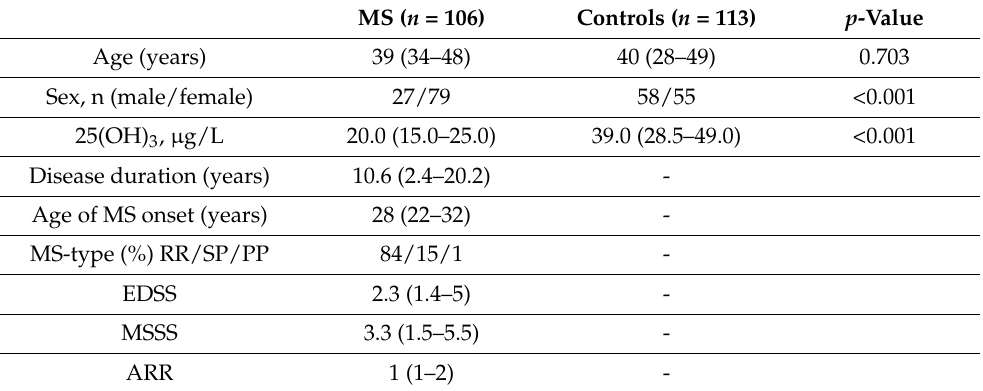
Table 2. Demographic and clinical characteristics of multiple sclerosis (MS) patients and controls.